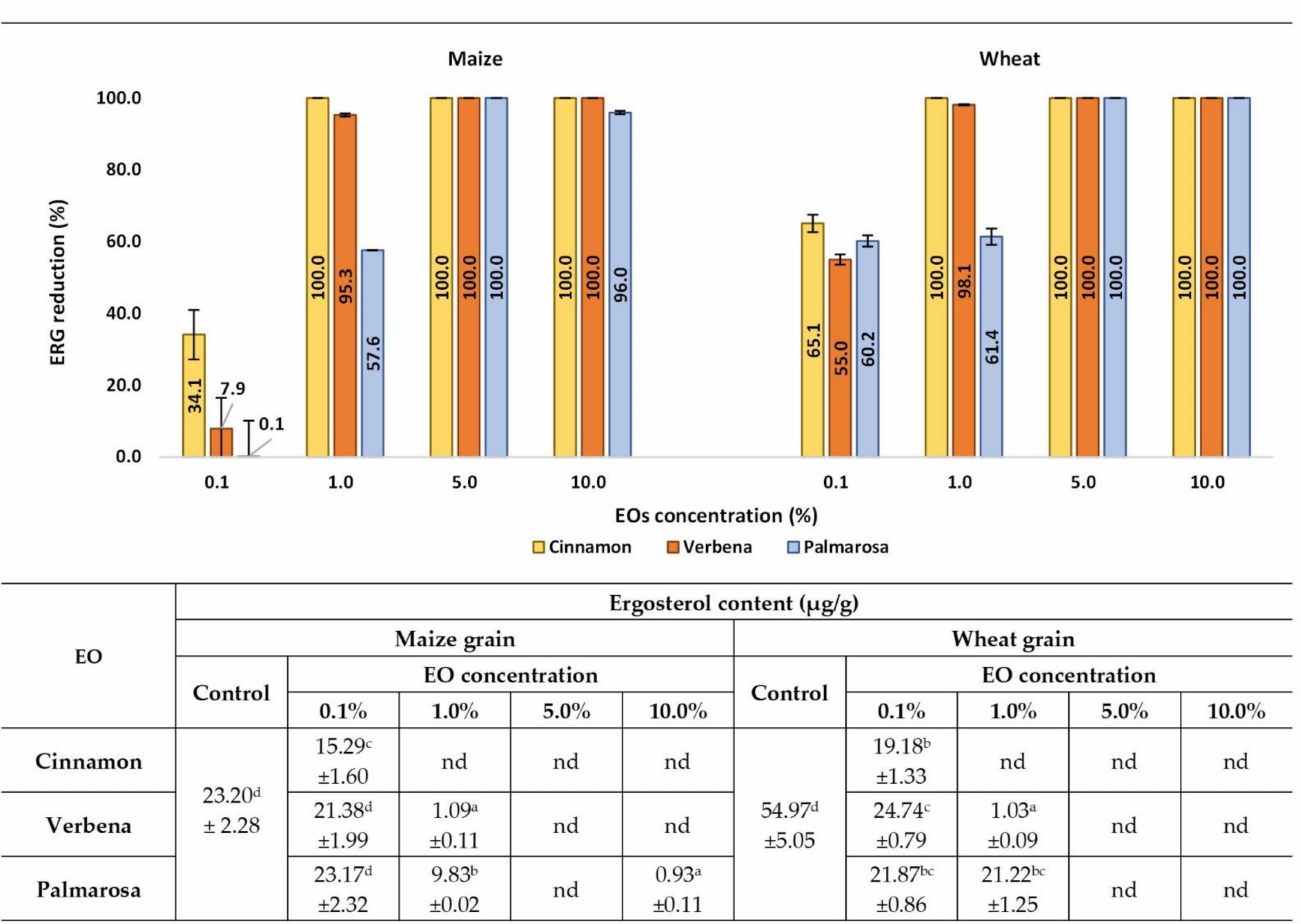
Figure 4. Effects of EOs on ERG contamination in maize and wheat samples after inoculation with the F. graminearum. nd-not detected, below the limit of quantification (<0.01 µ g/g). Averages with different letters (a–d) for each cereal are significantly different at the p <